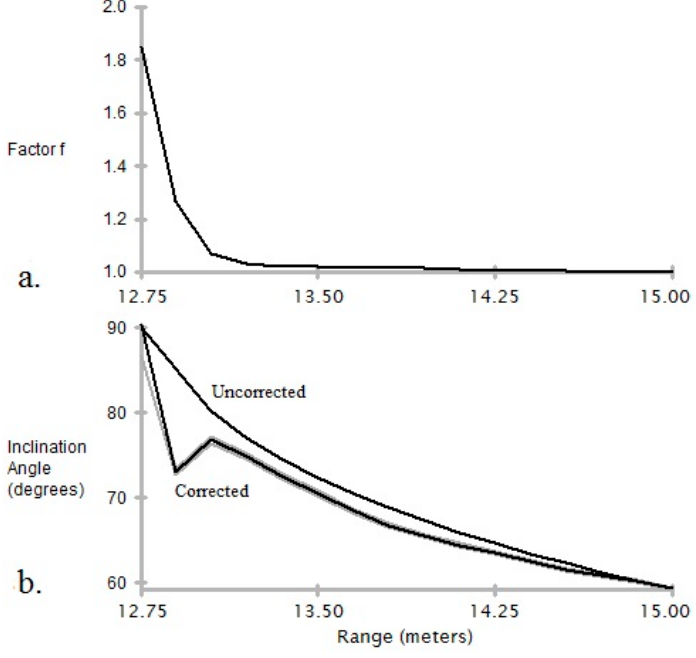
Figure 6. Graphs for a single sonar trace plotted as a function of range of: ( a ) The factor f ; and ( b ) Inclination angle (uncorrected θ ef fective , and corrected θ ), and with the corrected inclination angle the corresponding values for (cid:2016) (cid:2869) and (cid:2016) (cid:2870) in grey. The correction for (cid:2016) (cid:3032)(cid:3033)(cid:3033)(cid:3032)(cid:3030)(cid:3047)(cid:3036)(cid:3049)(cid:3032) and the computation of a non-unity value for (cid:1858) are not negligible